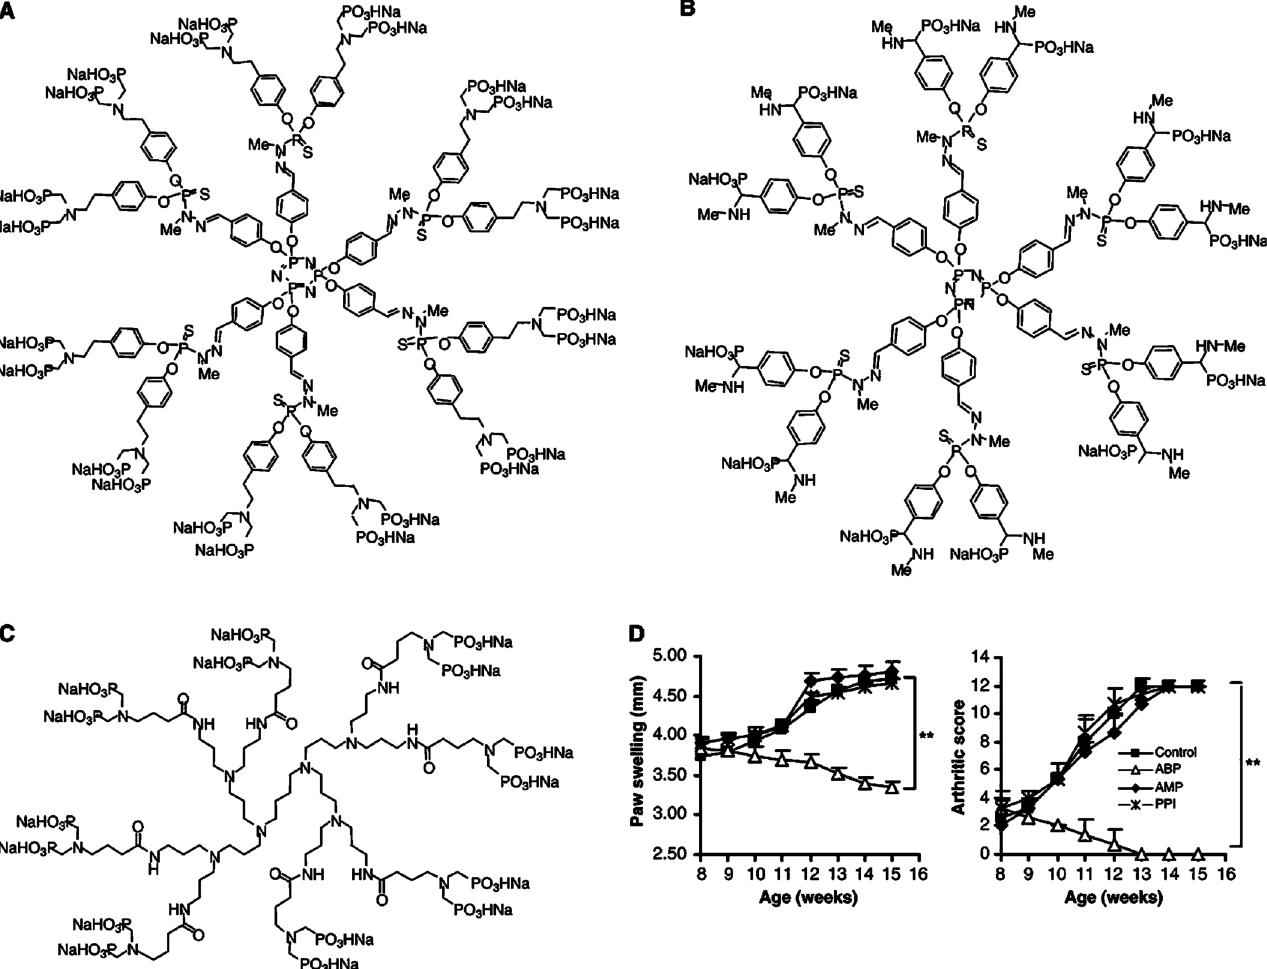
FIGURE 2 - Structure of dendrimers ABP (A), AMP (B) and PPI (C) used in IL-1ra -/- arthritis mice model studied by Hayder et al. (D) represent the comparative data of the effect of dendrimers ABP, AMP or PPI treated at a dose of 10 mg/kg on the development of external signs of arthritis (paw swelling and arthritic score) (Reprinted with permission from ACS Nano 2011, 5(9), 6779-6785. Copyright 2011 American Chemical